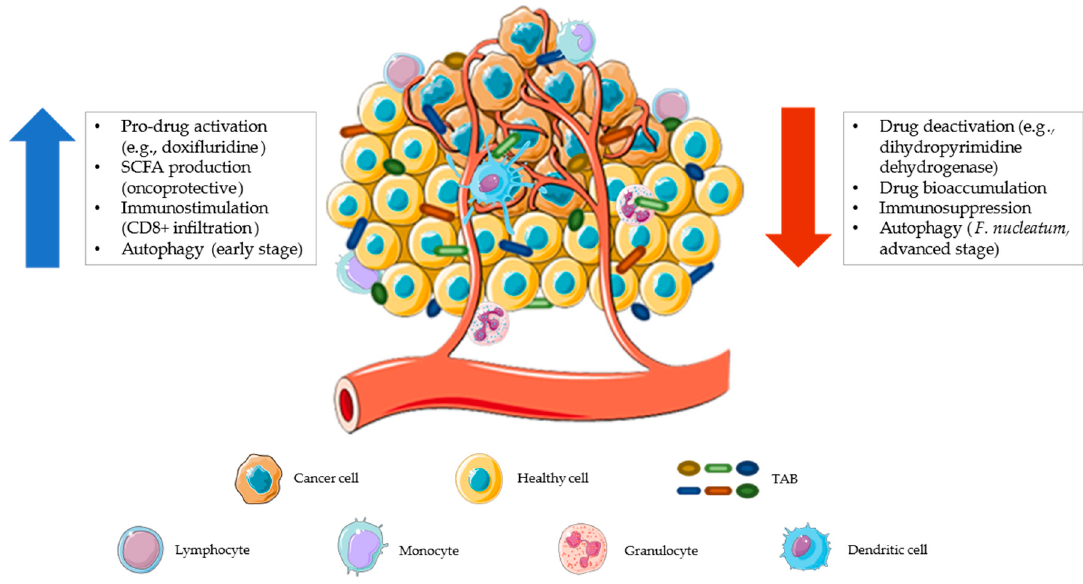
Figure 3. The tumor microenvironment represents a possible ecological niche for facultative and obligate anaerobic bacteria. The increased vascularization, promoted by tumor cells, makes this environment more accessible to leukocytes and bacteria that can interact closely with each other. This interaction can provide anti-tumoral or pro-tumoral activity. Tumor-associated bacteria (TAB) can contribute to anticancer drug resistance by reducing the amount of drugs in the microenvironment (by inactivation or bioaccumulation), exerting immunosuppressive activity, and/or promoting the autophagic pathway that reduces apoptosis [132] (red arrow). Conversely, a tumor microenvironment colonized by health-associated bacteria can contribute to a better therapeutic response by promoting localized pro-drug activation, producing short-chain fatty acids (SCFAs, which help maintain an onco-protective layout), stimulating tumor infiltration by immune cells (CD8+ T lymphocytes), and favoring early-stage autophagy (with antitumor activity [133]) (blue arrow). The figure was partly generated using Servier Medical Art, provided by Servier, licensed under a Creative